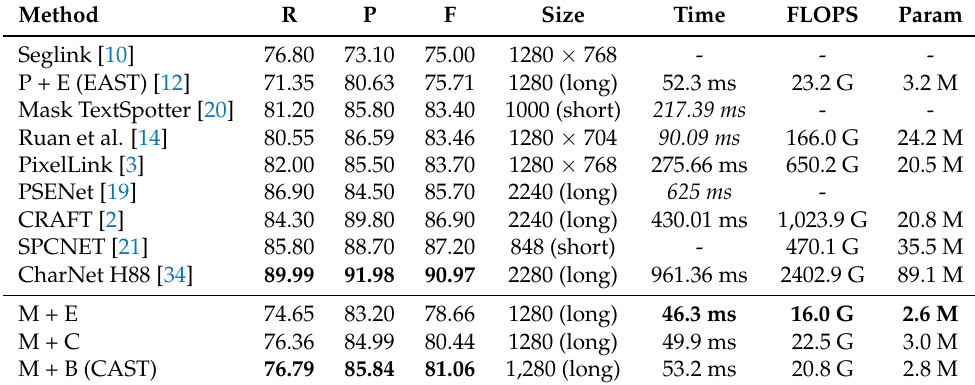
Table 2. Results with the ICDAR2015 dataset, where R , P , and F represent the recall, precision, and F1 score, respectively. M and P denote MobilNetV2 and Pvanet, respectively. E, C, and B are the EAST decoder, the CRAFT decoder, and our proposed balanced decoder, respectively. The inference time represents the time needed for obtaining a result for an image, where italic values indicate that the values are borrowed from other studies.